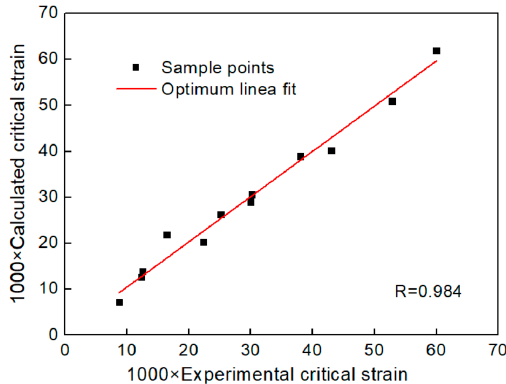
Figure 8. Correlation between the experimental critical strain and calculated critical strain.